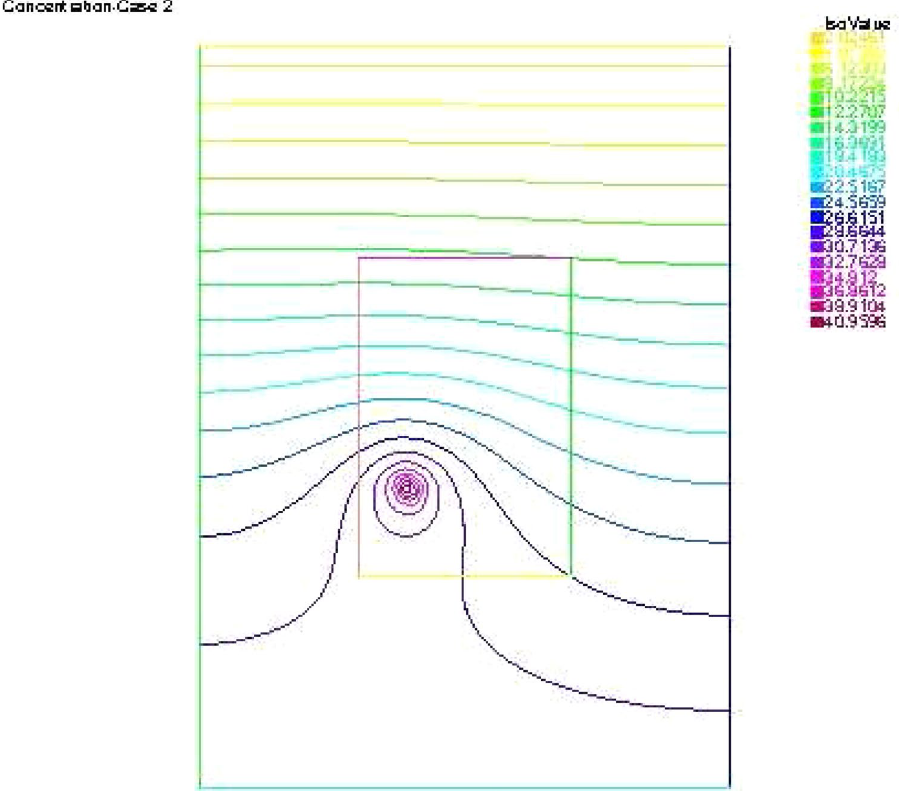
Figure 12. Pollutant concentrations—Case